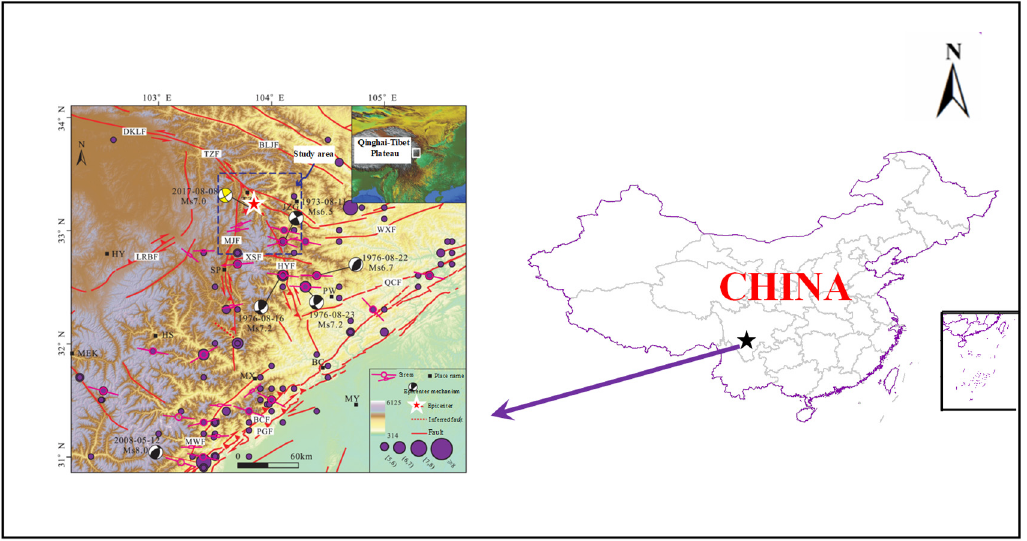
Figure 1. Geology of the Jiuzhaigou area and the location of the Jiuzhaigou